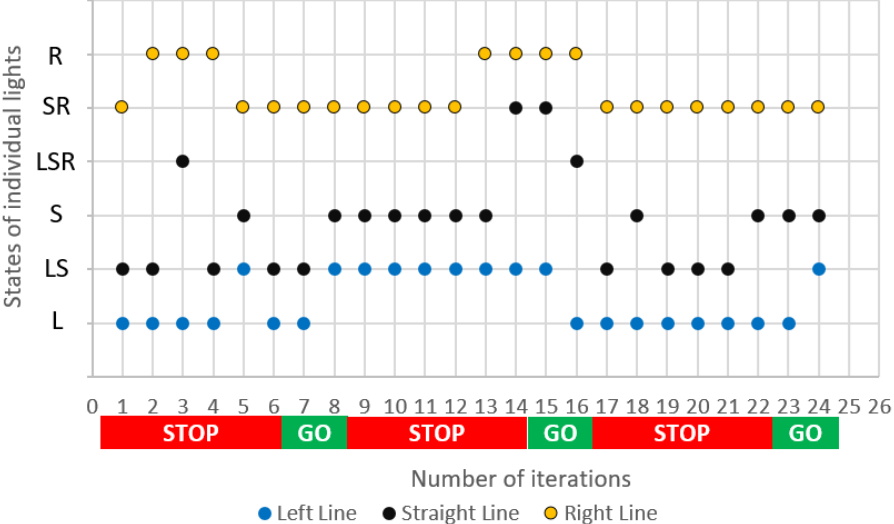
Figure 8. Changing states of lights in individual iterations of the